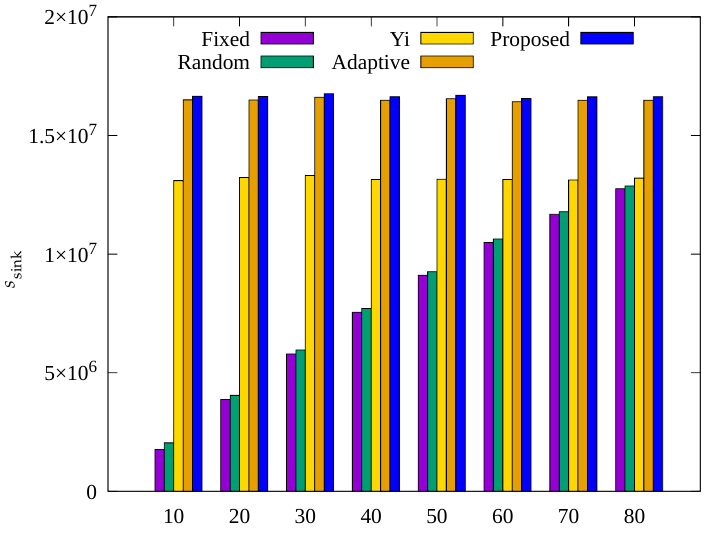
Figure 10. Comparison of the number of data gathered according to number of